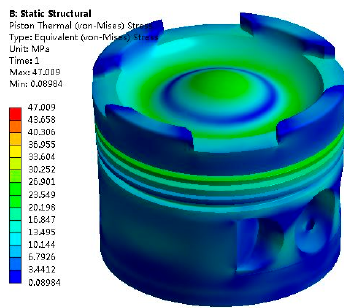
Figure 3. Piston thermal stress field.